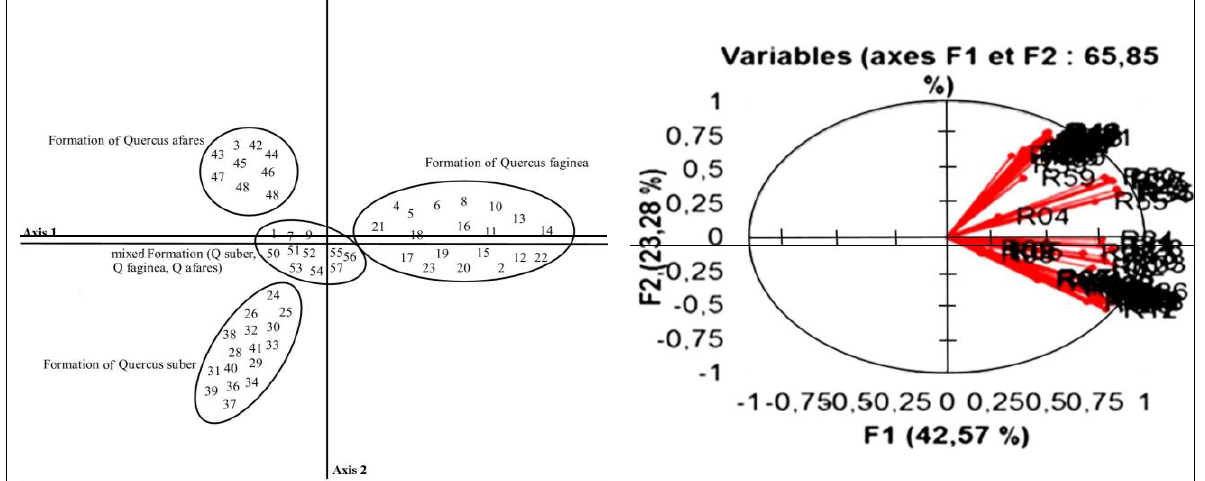
Fig. 4. Floristic analysis of the factorial map of the surveys